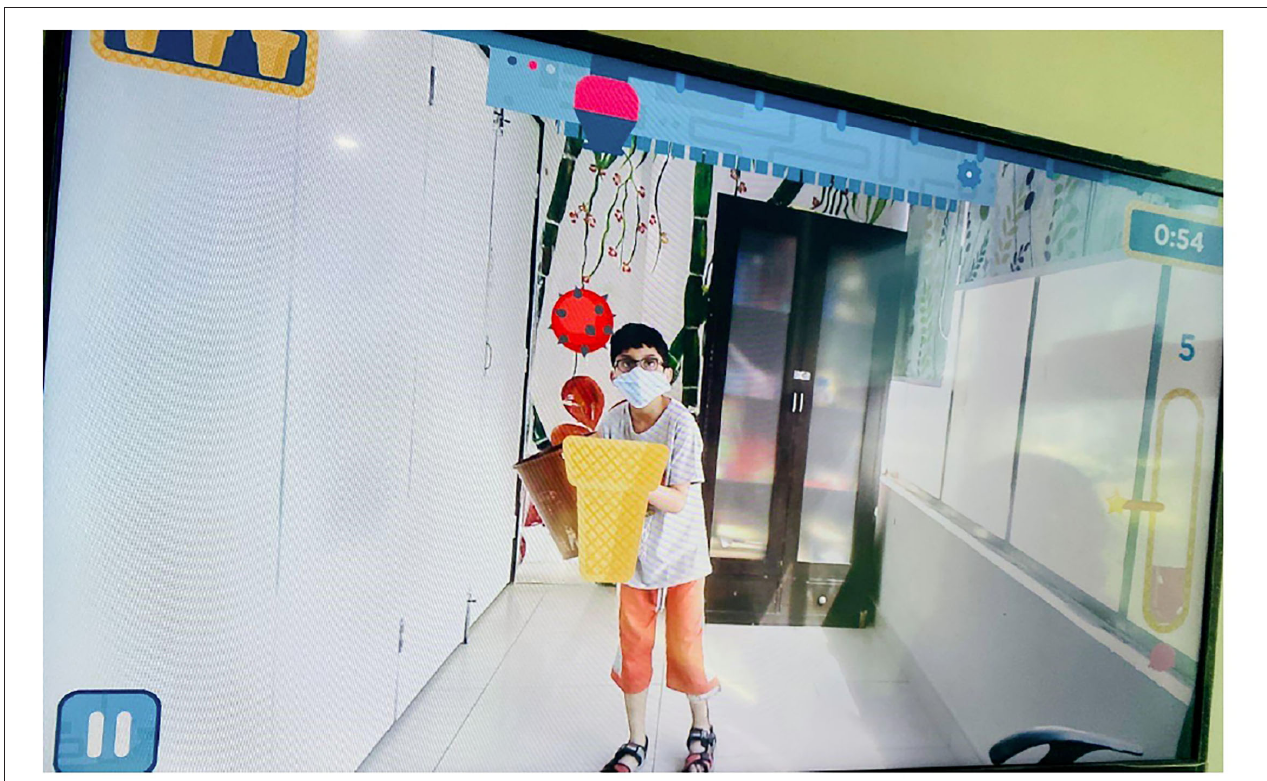
FIGURE 4 | Scoop’d (AR